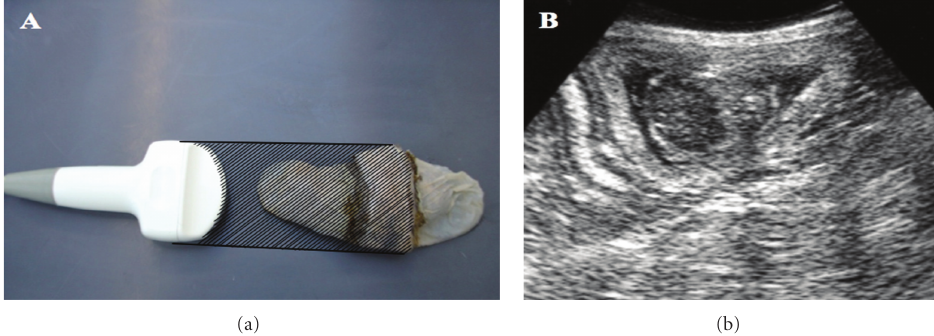
Figure 1: Planimetric image of the ultrasound beam’s action angle in the placenta ring. The hachured area represents the angle (approxi- mately 90 ◦ ) of the beam’s incidence on the placenta ring pars intermedia, the point where thickness measurements were performed (a). (b) Corresponding ultrasound